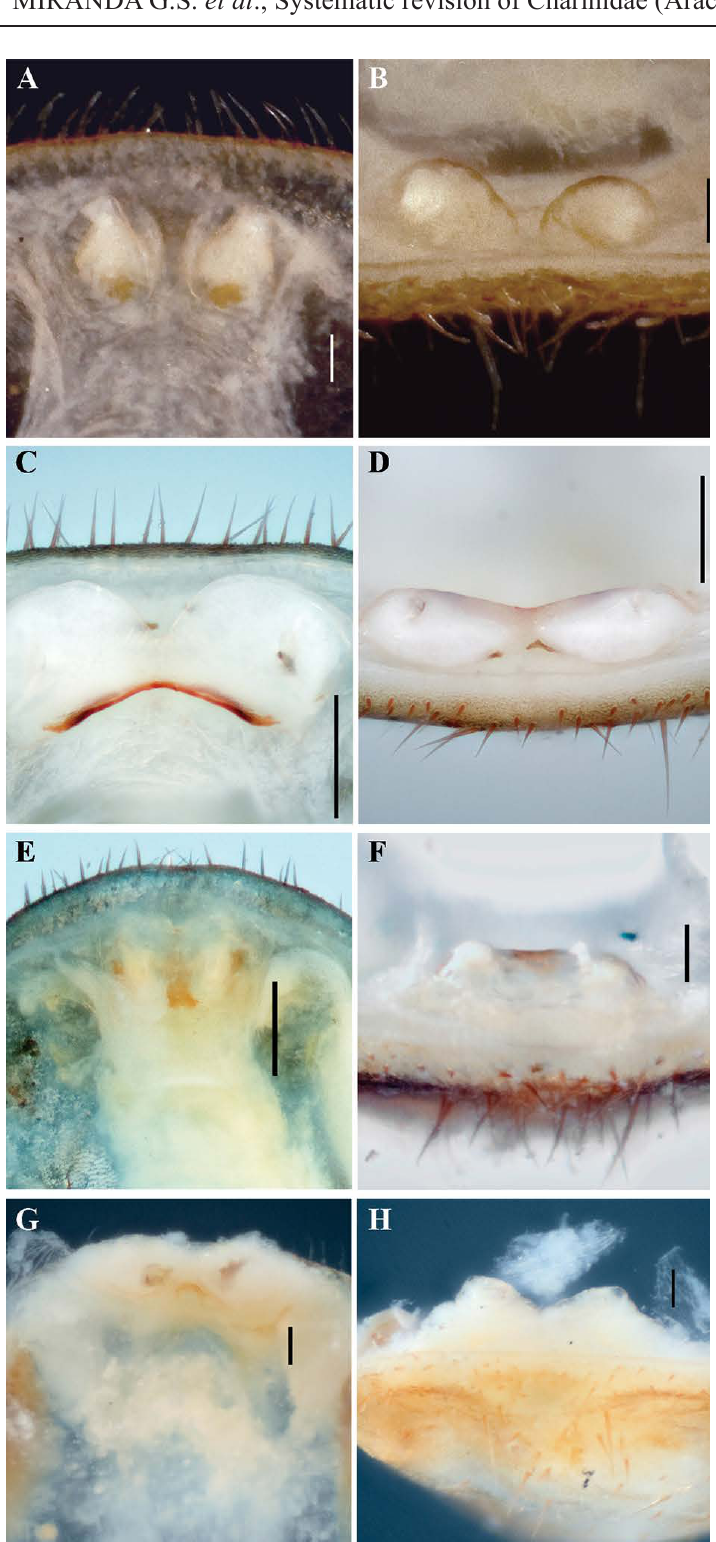
Fig. 5. Charinus Simon, 1892, female gonopods, dorsal (left column) and posterior (right column) views. A–B . Charinus apiaca sp. nov. (MNRJ 9286). C–D . Charinus gertschi Goodnight & Goodnight, 1946 (AMCC [LP 10076]). E–F . Charinus miskito sp. nov. (SMNS). G–H . Charinus mocoa sp. nov. (SMF 68). Scale bars: A–B, F–H = 0.1 mm; C–E, I–L =